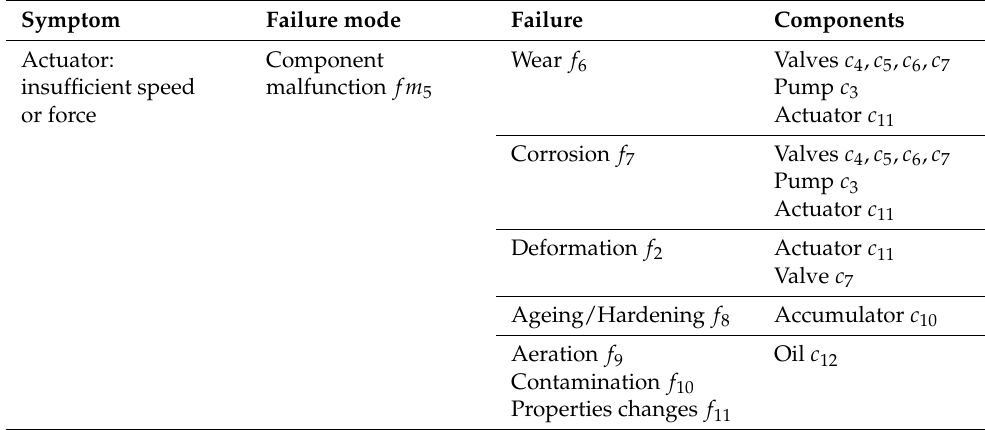
Table 2. Functional failures ( f f 2 ) : System is partially able to perform the intended function.